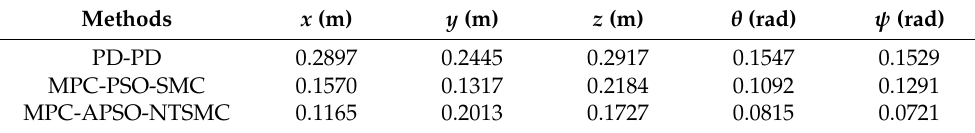
Figure 12. Velocity tracking of the AUV without disturbance for Case 1. Table 3. Position MAE without disturbance after 20 s for Case